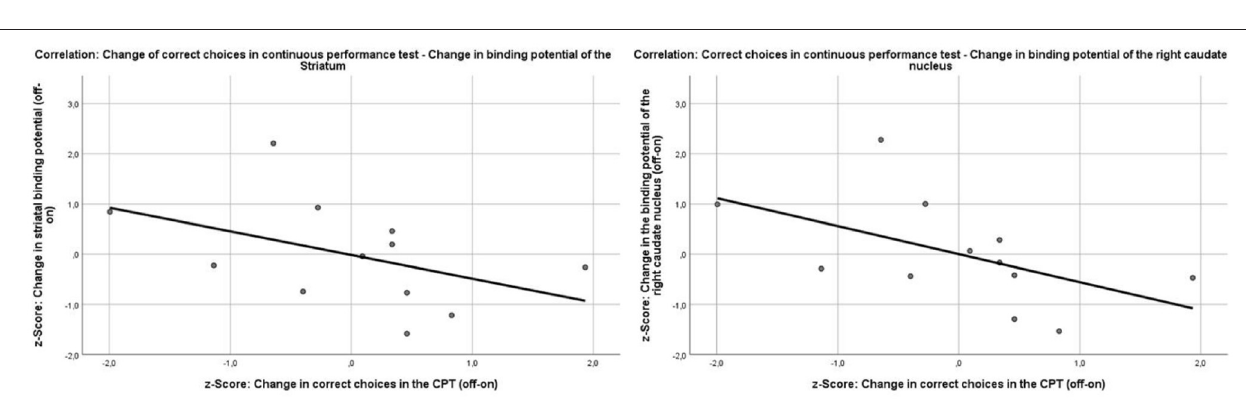
DAT binding (likely reflecting a change in striatal DA